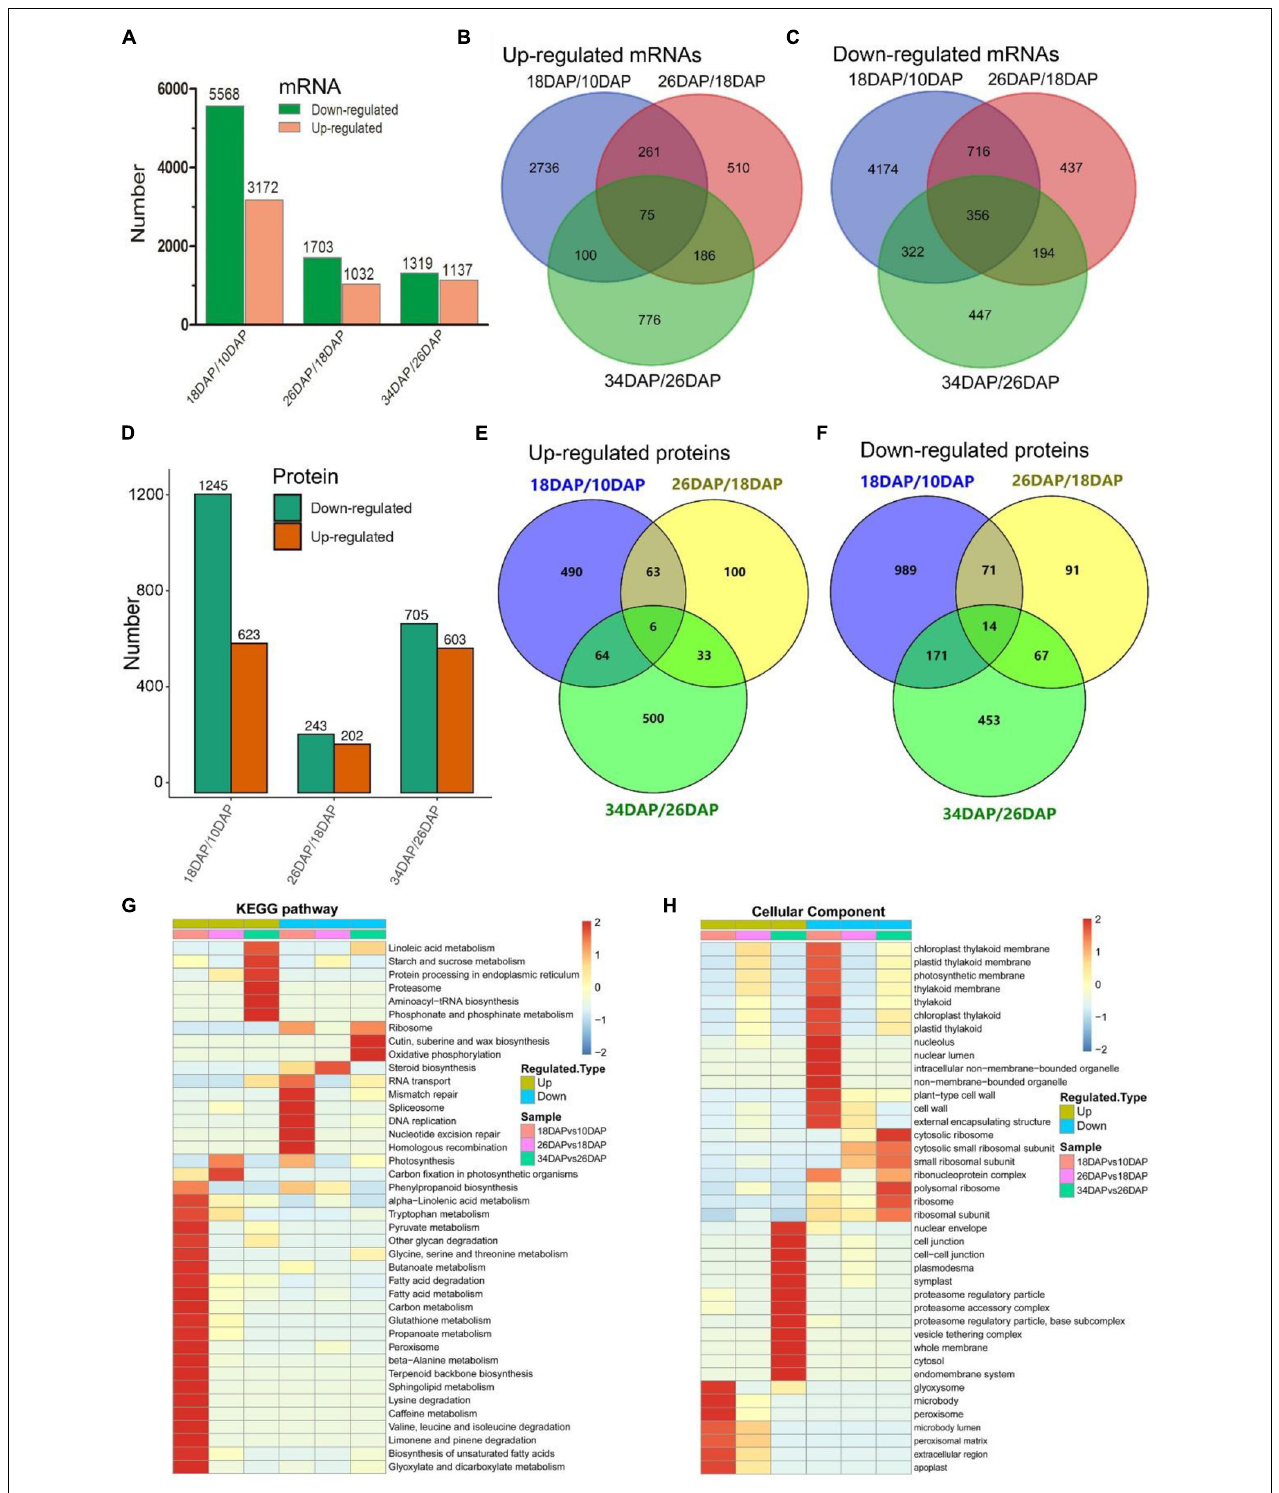
FIGURE 2 | RNA-seq and TMT-labeled quantitative proteomics analyses of watermelon fruit development and ripening. (A,D) Differentially expressed genes and proteins statistics of three groups (18 DAP vs 10 DAP, 26 DAP vs 18 DAP, and 34 DAP vs 26 DAP). Venn diagrams of up-regulated mRNAs (B) , down-regulated mRNAs (C) , up-regulated proteins (E) , down-regulated proteins (F) in three groups. (G,H) Hierarchical clustering analysis of KEGG pathways and GO terms (cellular components) in three groups.